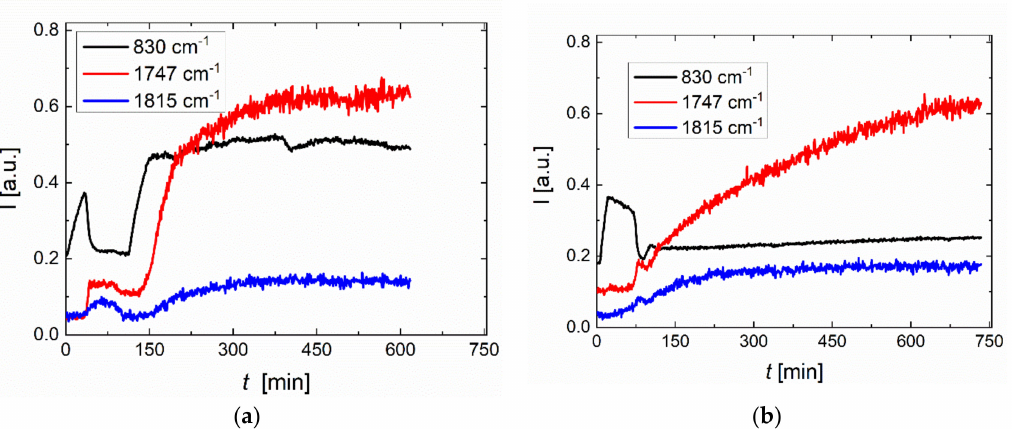
Figure 5. IR absorbance of ring-deformation mode of PO (black), cPC (blue), and C = O vibration mode of resulting PPEC (red) during semi-batch experiments in 2 L autoclave at T = 90 ◦ C ( a ) and T = 120 ◦ C ( b ) at 10 bar CO 2 pressure, including the activation procedure and